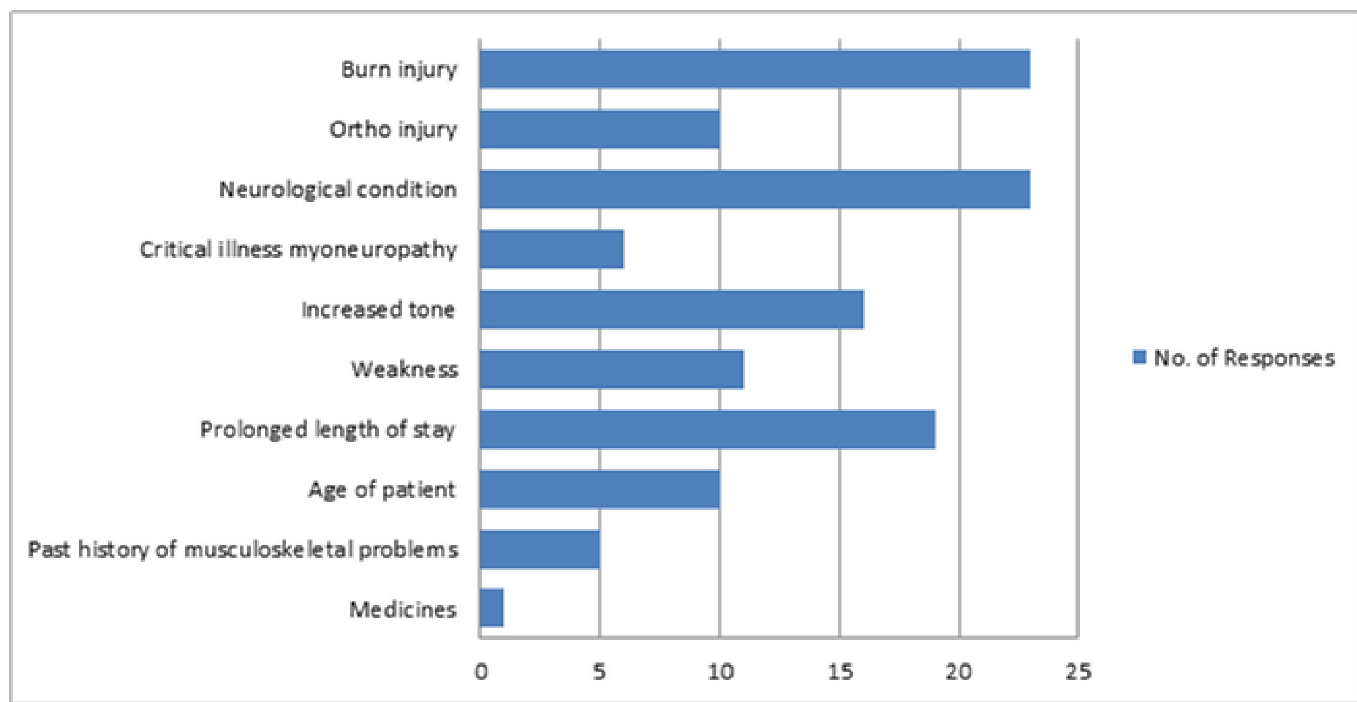
Fig 4. Frequencies for predisposing factors for loss of passive limb range of motion reported by the 33